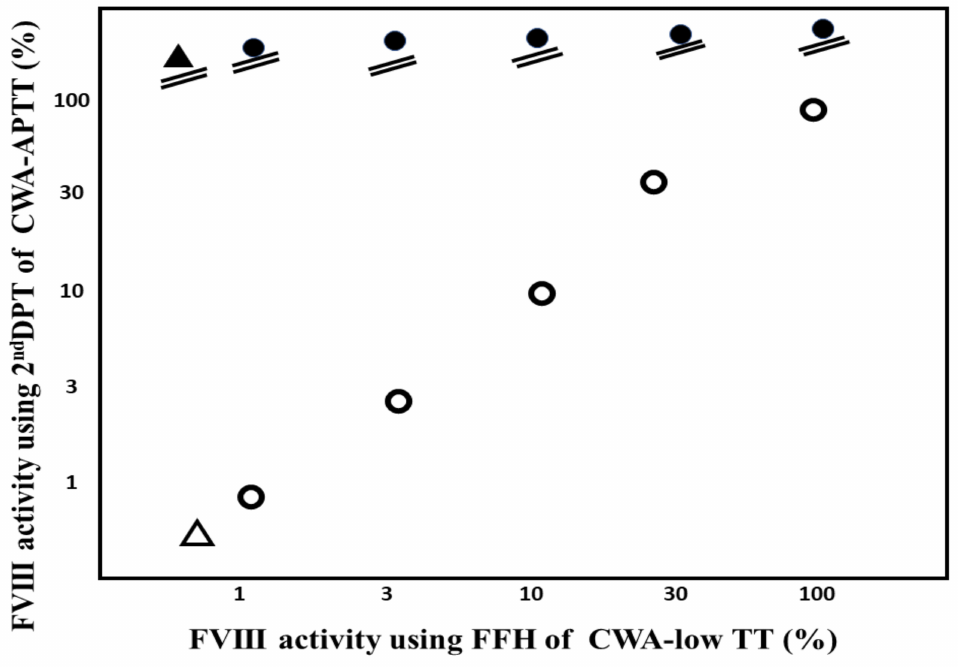
Figure 6. FVIII activity using the 2nd DPT of CWA-APTT or CWA low TT. CWA, clot wave analysis; APTT, activated partial thromboplastin time; low TT, low concentration of thrombin time; • , various concentrations of FVIII plasma with emicizumab; , various concentrations of FVIII plasma with (cid:35) emicizumab; (cid:78) , hemophilia A patient with inhibitor treated with emicizumab; (cid:52) , hemophilia A patient without inhibitor treated without